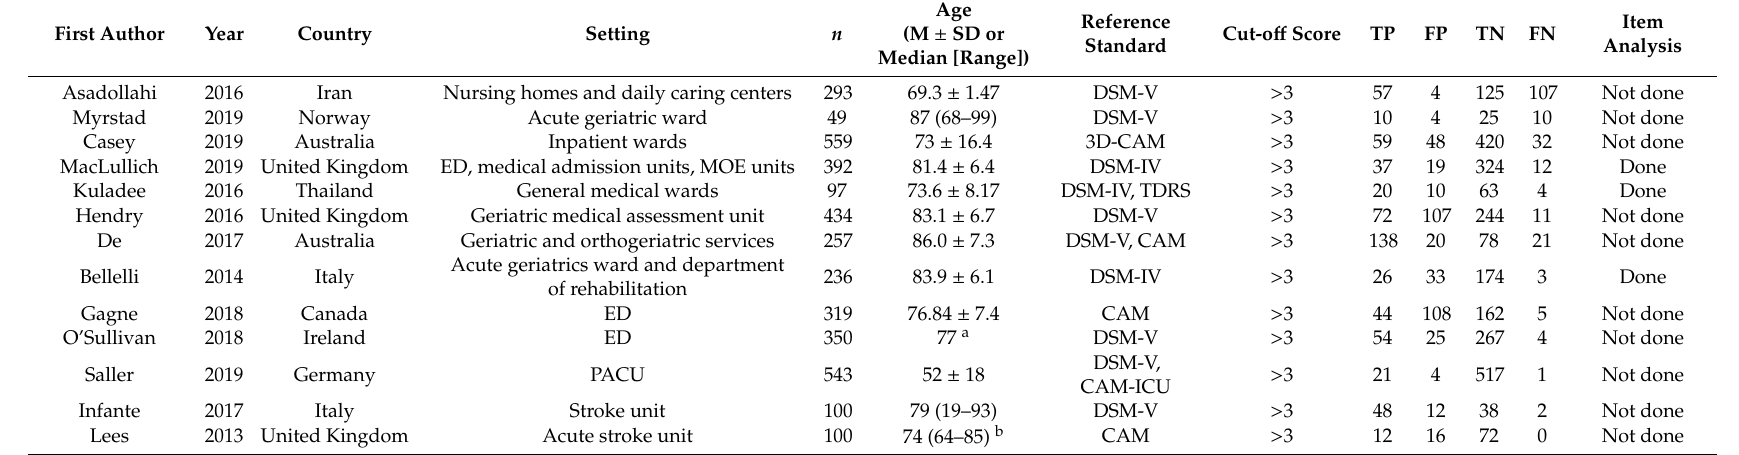
Table 1. Characteristics of the studies that were systematically